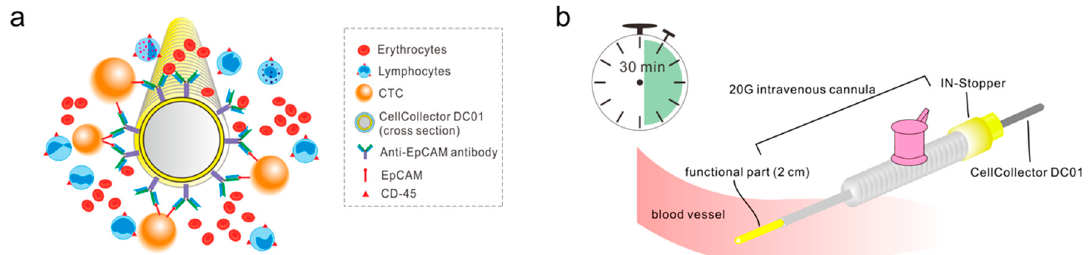
Figure 1. Schematic drawing of the CellCollector CANCER01 (DC01) and the application procedure. ( a ) Working principles of DC01 viewed from its cross section. A medical wire coated with hydrogel is functionalized with antibodies against epithelial cell adhesion molecule (EpCAM). Cancer cells expressing EpCAM antigen are targeted and captured onto the functional part. ( b ) Demonstration of application procedure of DC01 in vivo. The DC01 is applied into the cubital vein of the patient via a 20-gauge intravenous cannula fixed with a yellow IN-Stopper. The functional part is exposed to the blood flow for 30 min allowing the e ffi cient detection of potential circulating tumor cells